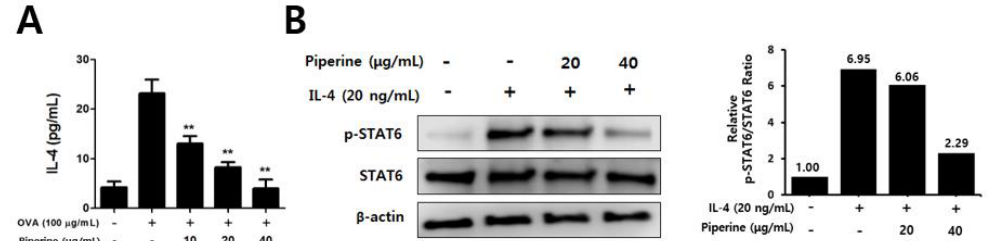
Figure 5. Effect of piperine treatment on IL-4 production in OVA-immunized splenocytes and on IL- 4-mediated STAT6 phosphorylation in CD4 + T cells. ( A ) For the analysis of IL-4 cytokine production, the splenocytes isolated from OVA-immunized BALB/c mice were seeded to 5 × 10 6 cells/mL and cultured in the presence or absence of OVA (100 μg/mL) with piperine. ( B ) To detect STAT6 phosphorylation, CD4 + T cells isolated from splenocytes of a BALB/c mouse were pre-treated with piperine for 1 h before IL-4 (20 ng/mL) treatment for 15 min. The results are shown as the means ± SD ( n = 3). Asterisks (**) indicate significant differences between the piperine-treated and non-treated groups at p < 0.01.